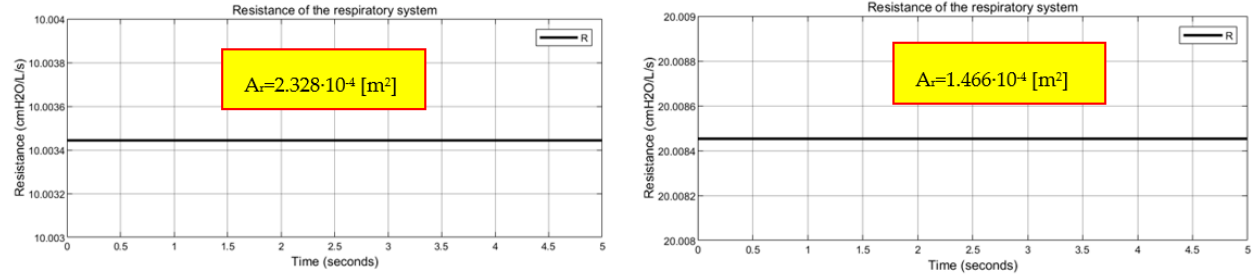
Figure A2. Resistance values of the respiratory obtained through the airway resistance simulation code.